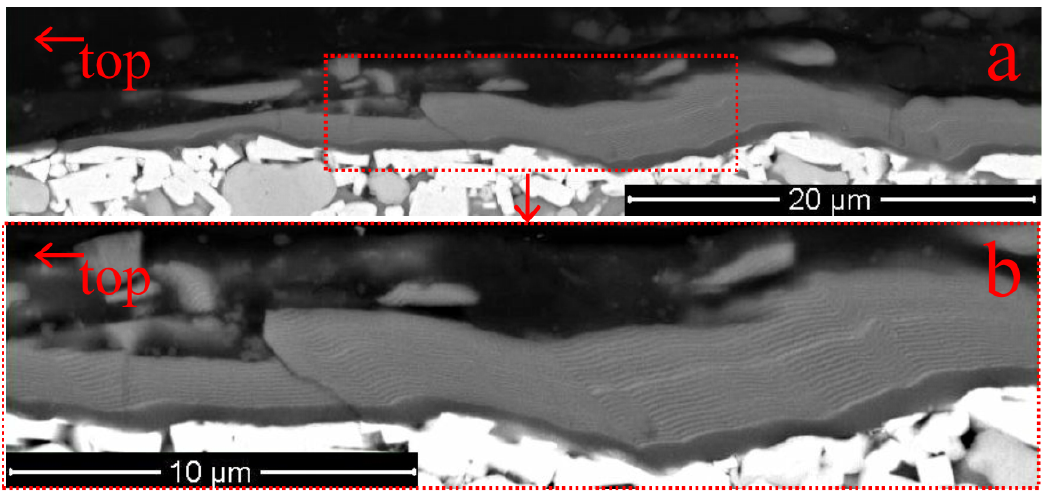
Figure 8. Fracture patterns for Ti-TiN-(Ti,Cr,Mo,Al)N coating ( a , b ) on the flank faces of the tools (90° counterclockwise, top left (SEM).